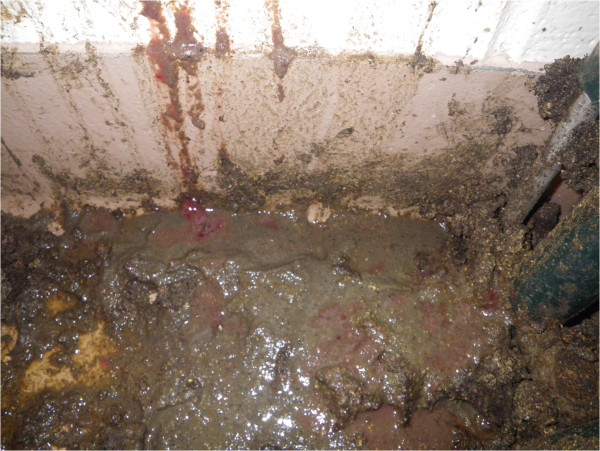
Mucohemorrhagic diarrhea. Accumulation of loose and runny feces with mucus and frank blood. Pig #675, 11 days post inoculation, day of first observation of mucohemorrhagic diarrhea, 7th day of “B. hampsonii” strain 30599 shedding, feces culture positive (3+ strongly beta-hemolytic “B. hampsonii” strain 30599) on this day, 1.86 × 108 strain 30599 genomic equivalents/g. In inoculated pigs the severity of bloody diarrhea ranged from that containing a few flecks of blood to diffusely hemorrhagic with copious blood and mucus as shown.